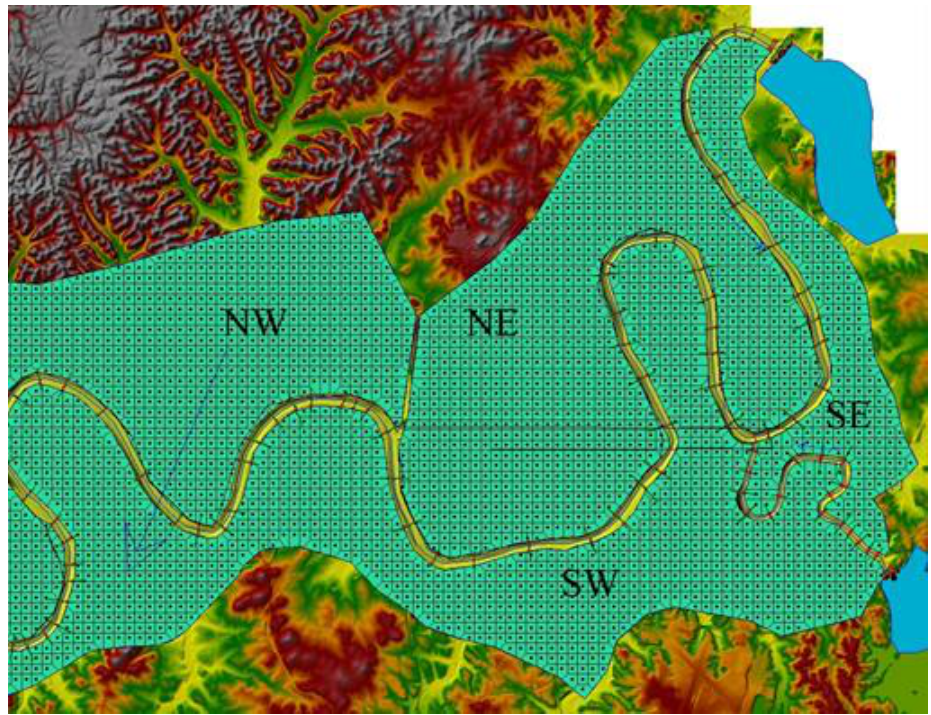
Figure 7. Combined one- and two- dimensional areas downstream of Old Hickory and JPP (the blue arrow indicates the general flow direction from NE to SW).